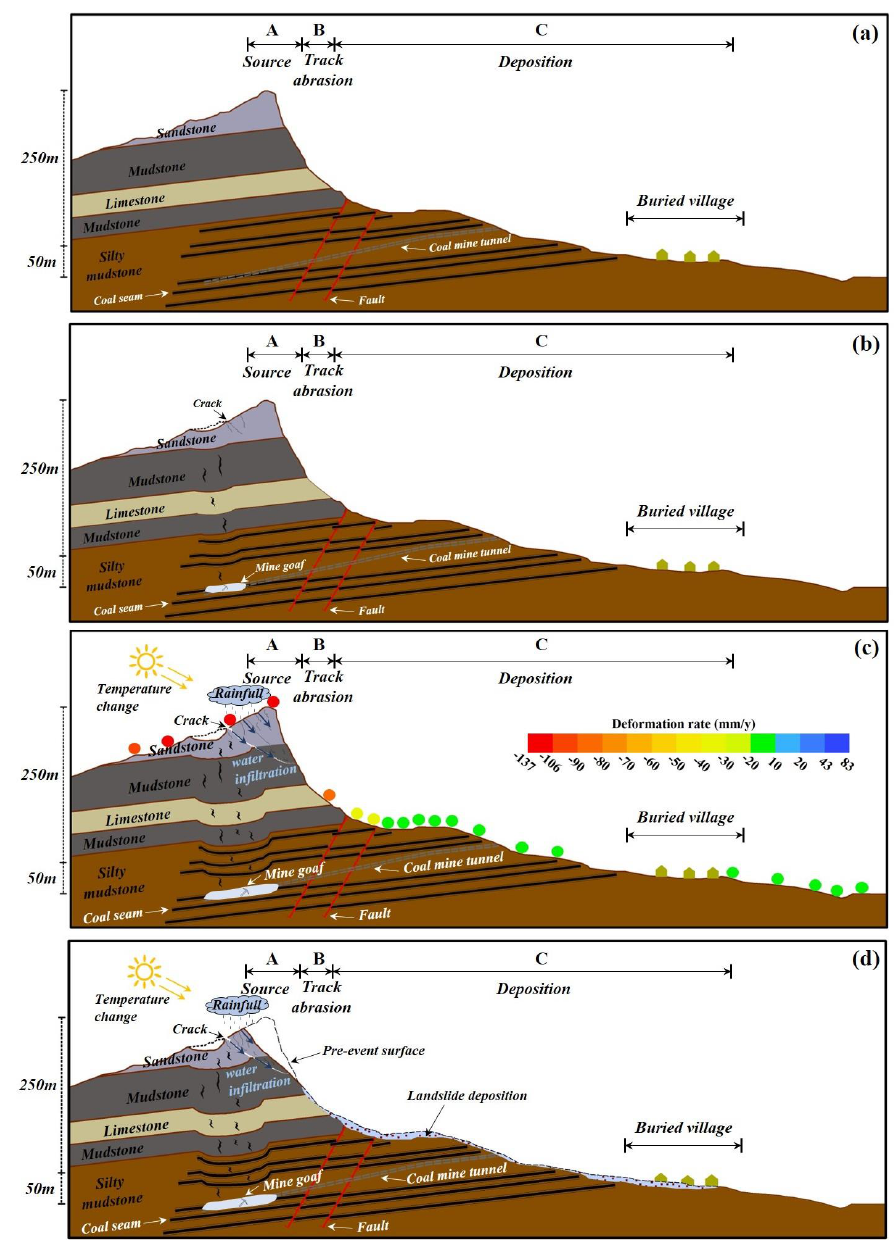
Figure 12. The conceptual failure mechanism of the Pusa landslide. The location of the profile is shown in Figures 2a and 8b. ( a ) The initial state of the landslide. ( b ) Land subsidence and cracks occurrence on the surface with underground mining. ( c ) Temperature variation and rainfall aggravates the development of cracks, the colored points indicate the annual deformation rate along the profile calculated by descending Sentinel-1 datasets, shown in Figure 8b. ( d ) Profile after landslide event, including source section, track abrasion section, and deposition section.